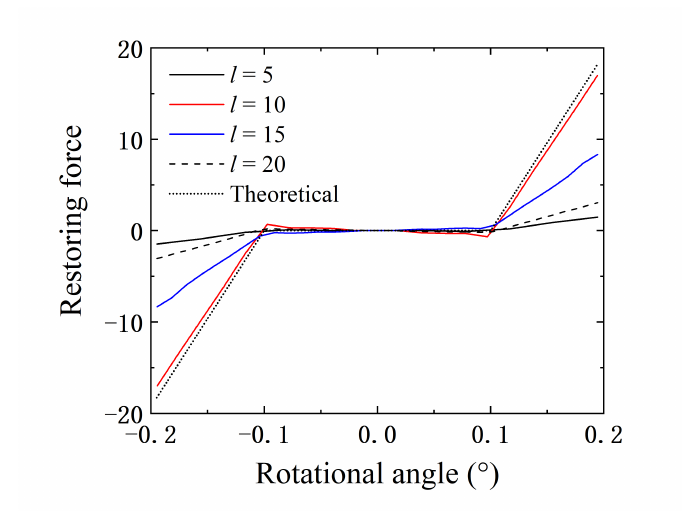
Figure 8. The reconstruction of restoring force of central freeplay under different divisions.